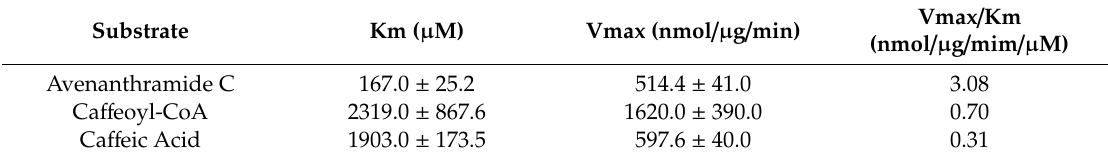
Figure 3. In vitro assays of CCoAOMT using the protein expressed in E. coli on three substrates. HPLC analysis of the products in the presence of S-adenosyl methionine with Avn-C ( A ), caffeoyl-CoA ( B ) and caffeic acid ( C ). Table 1. Kinetic parameters of oat CCoAOMT enzyme with three substrates.